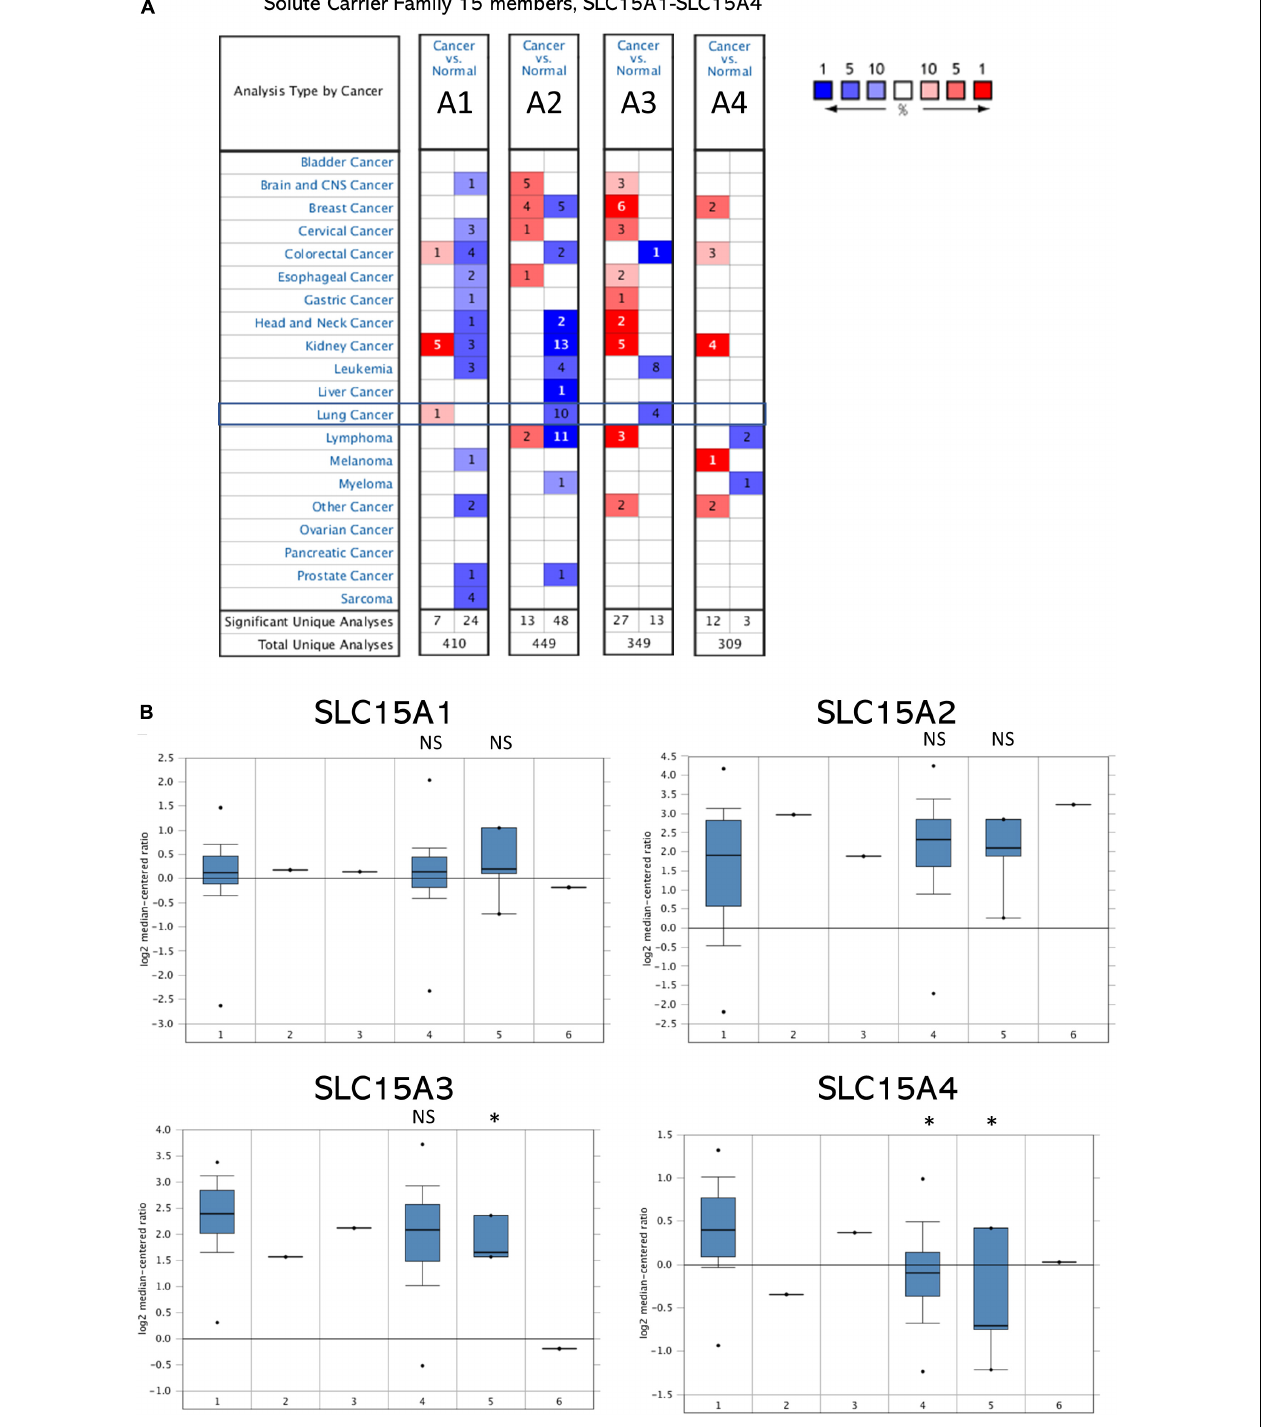
FIGURE 1 | (A) Pan-cancer analysis of SLC15A family genes within the Oncomine database. Lung cancer is indicated in the frame. Cells on red background with numbers show research within our selection standard in cancer tissue; blue in normal tissues. A1 = SLC15A1, A2 = SLC15A2, A3 = SLC15A3, and A4 = SLC15A4. Blue color indicates down-regulated genes percent and red color is for up-regulated genes percent. Number in the cell is for the research cases matched with our selection. (B) The RNA-Seq profile of SLC15A family members from TCGA lung cancer with detailed subtypes. 1, lung adenocarcinoma (30 cases); 2, lung adenocarcinoma, mixed subtypes (1 case); 3, Lung clear cell adenocarcinoma (1 case); 4, squamous cell lung carcinoma ( n = 149); 5, squamous cell carcinoma, basaloid variant ( n = 5); 6, squamous cell lung carcinoma, papillary variant ( n = 1). NS, not statistically significant. ∗ P value < 0.05.